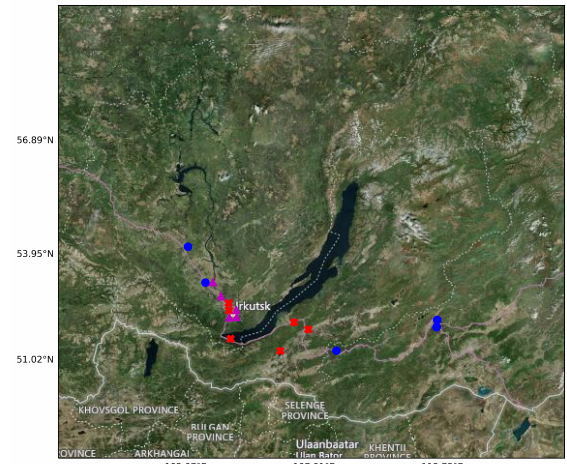
Figure 3. Geographical domain and the monitoring site locations collecting time series (red crosses), pointwise measurements (blue circles) and integral measurements (magenta triangles) of ozone ( O 3 ) concentrations.